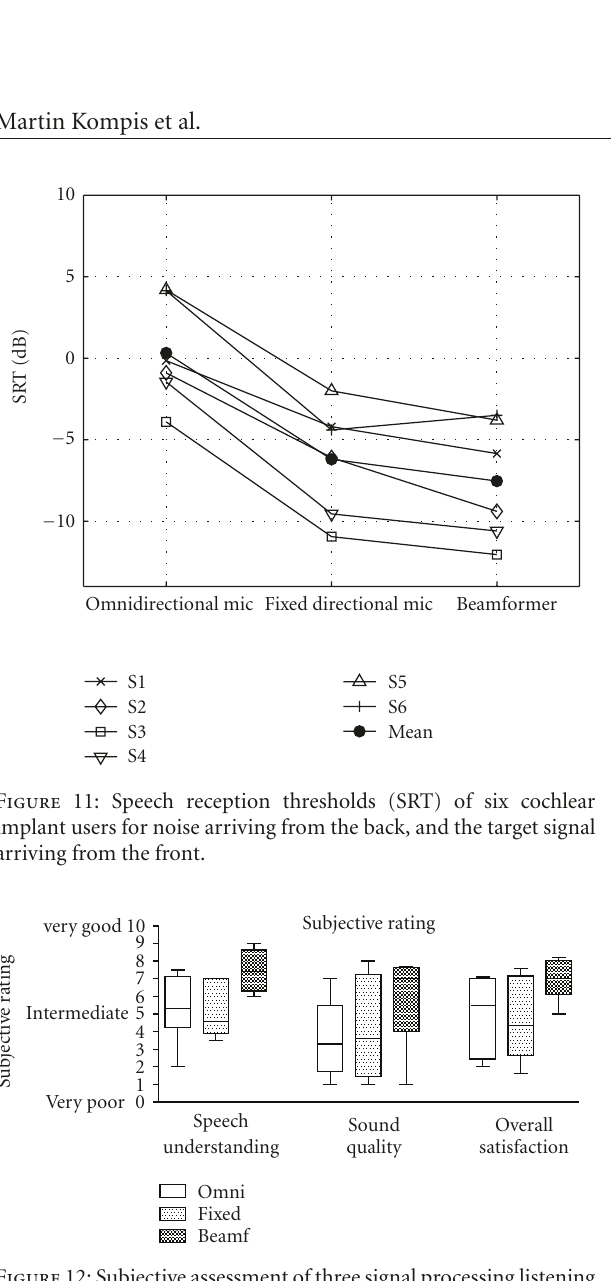
Figure 12: Subjective assessment of three signal processing listening conditions by the cochlear implant users in a cafeteria at lunch time. Box plots denote minima, maxima, and quartiles of the subjective ratings on a visual analogue